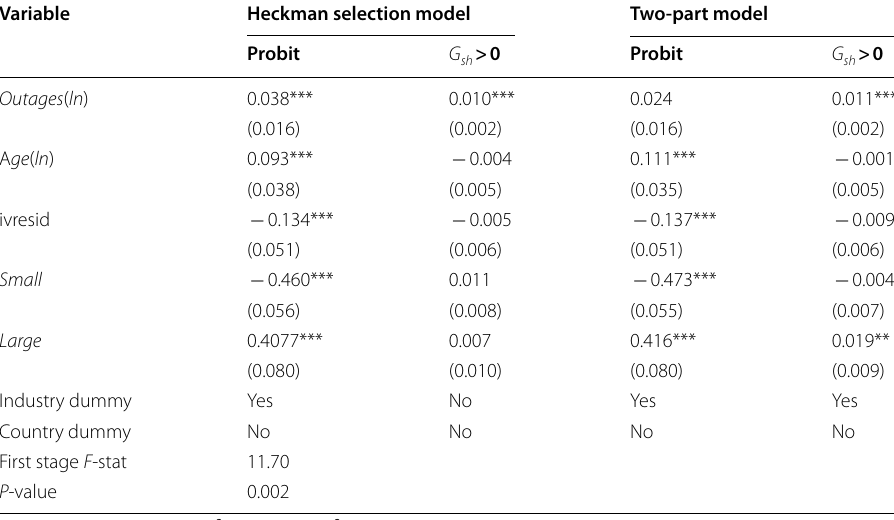
Table 7 Instrumental variable